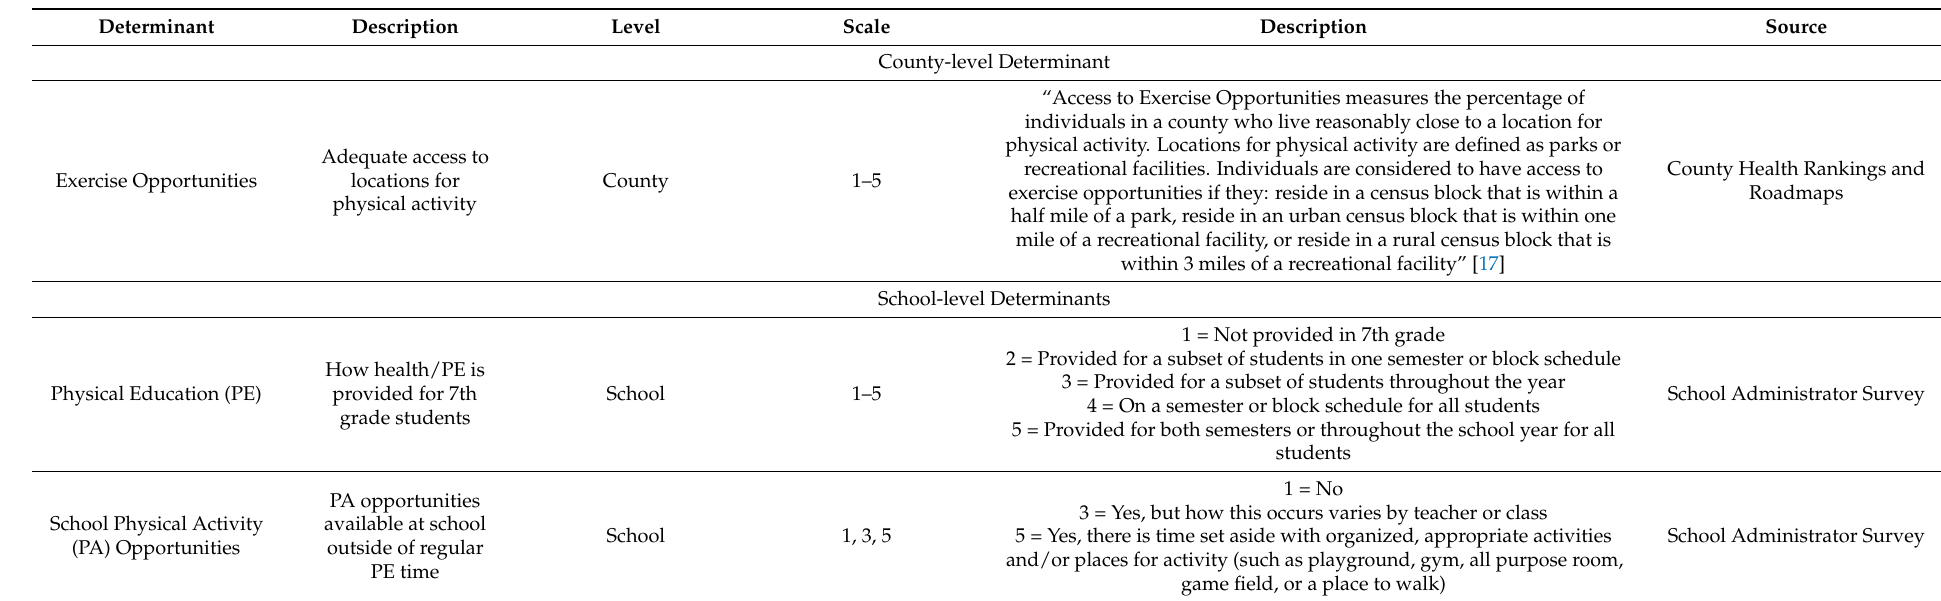
Table 1. Details of how county- and school-level determinants were